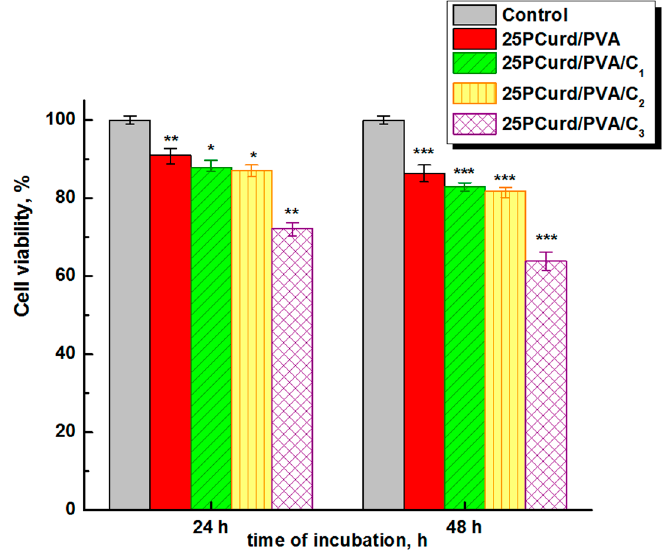
Figure 8. Cells viability of nanofibre 25PCurd/PVA with and without cove oil after 24 and 48 h (* p < 0.001, ** p < 0.01, *** p < 0.05). (* p < 0.001, ** p < 0.01, *** p <